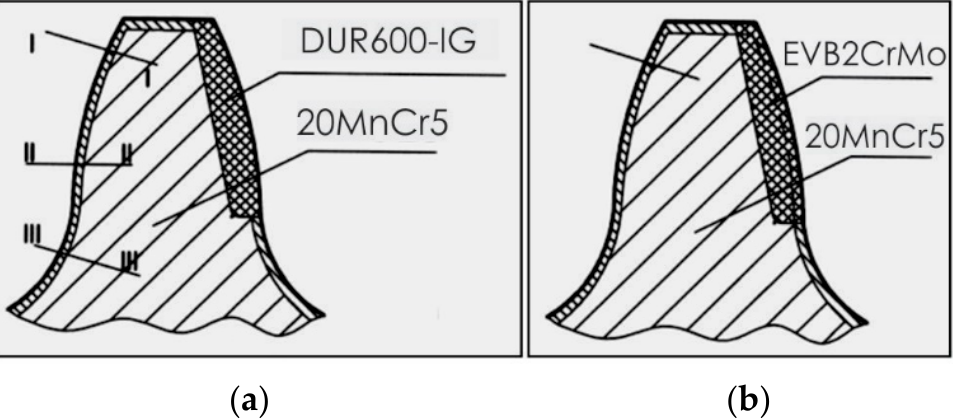
Figure 8. Microhardness measurement results for the tooth hard-faced with FM EVB2CrMo.